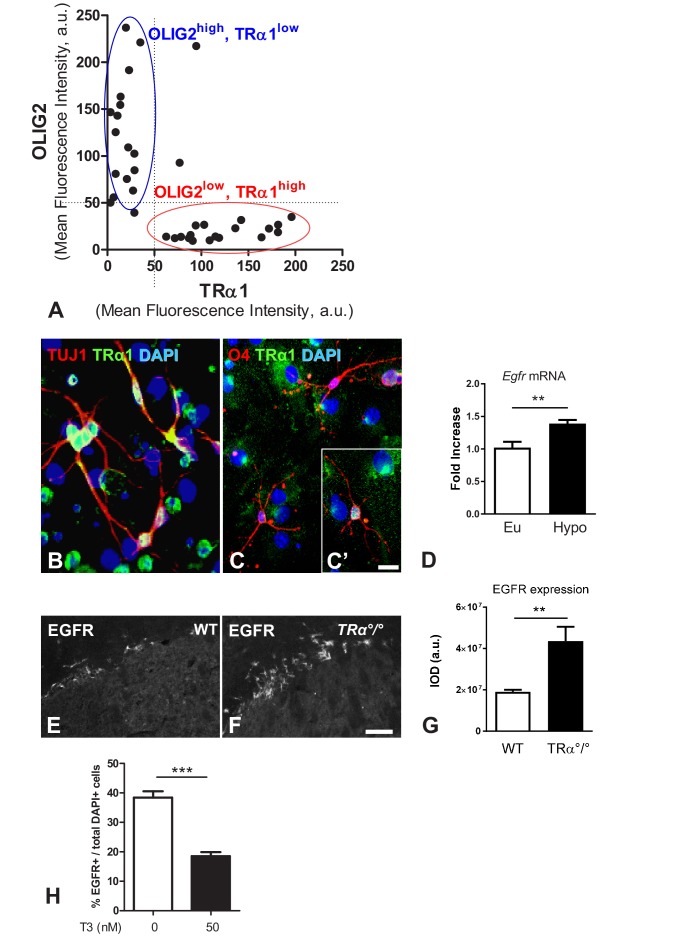
TRα1 signalling is associated with a neuronal fate in vitro and in vivo.(A) Analysis of TRα1 (β-Gal) and OLIG2 fluorescent signals. Two distinct cell populations are discriminated: a population of OLIG2high/TRα1low (blue circle) is clustered as a separate population of OLIG2low/TRα1high (red circle). (B–C’) Neurospheres were generated from SVZ sampled from WT adult mice. Dissociated cells from neurospheres were induced to differentiate. Following 7 days differentiation, immunolabelling for TRα1 (green), the neuronal marker TUJ1 (red, B), the oligodendrocyte marker O4 (red, C and C’) were performed. Endogenous TRα1 is detected in all TUJ1+ neuronal cells (B) and can be found in more mature O4+ glial cells (C and C'). DAPI nuclear staining revealed all cells in the slides. Scale bar: 5 µm. (D) T3 represses Egfr expression in the adult SVZ. SVZ of long-term hypothyroid adult mouse brains (versus euthyroid) were dissected and Egfr mRNA quantified by qPCR and normalized against GAPDH using the DDCt method. Egfr levels are given as a function of control levels. (mean ± SEM, Pooled data from three experiments are given, n > 12 mice, **p=0.008, U = 4, Mann-Whitney test). (E and F) Immunodetection of EGFR in the dorsal part of the SVZ from WT (E) or TRα°/° (F) adult mice showing that TRα1 loss of function increases the EGFR+ population in the adult mouse SVZ. Scale bar: 50 µm. (G) Quantification of EGFR signal in the dorsal part of the adult SVZ of WT versus TRa°/° mice (Data are presented as mean IOD ± SEM, n = 8, 4 slices from 2 animals, **p=0.0022, U = 3, Mann Whitney test). IOD, Integrated Optical Density. (H) Quantified proportion of EGFR-positive cells after 7 days differentiation in presence or not of T3 (50 nM). (mean ±SEM, n = 16, ***p=0.0002, Mann-Whitney test).